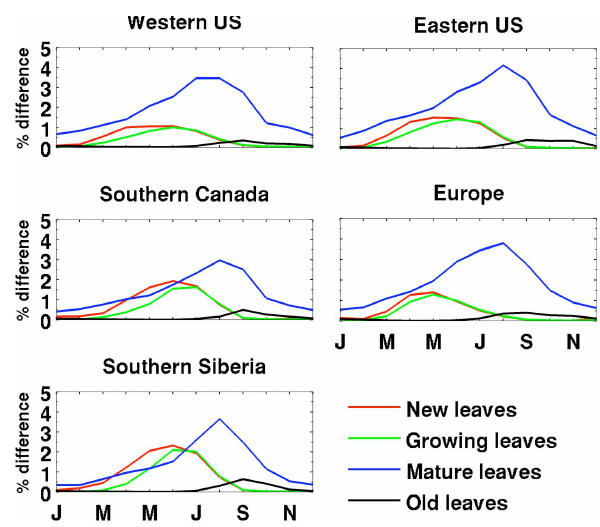
Fig. 6. 2009 timelines of the percent difference in the total col- umn methanol from GEOS-Chem for a 10% increase in the relative emissions from new leaves (red), growing leaves (green), mature leaves (blue), and old leaves (black) for the five regions considered in this study (Fig. S2). Lines show the mean over each